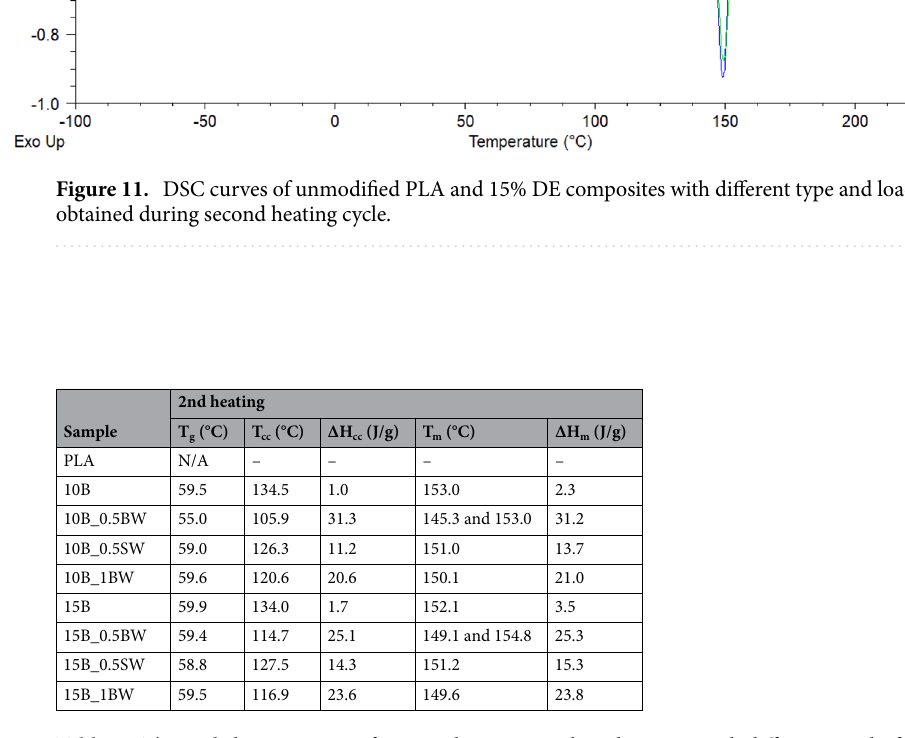
Table 4. Thermal characteristics of PLA and composites based on PLA with different weight fraction of diatoms and different kind of waxes.